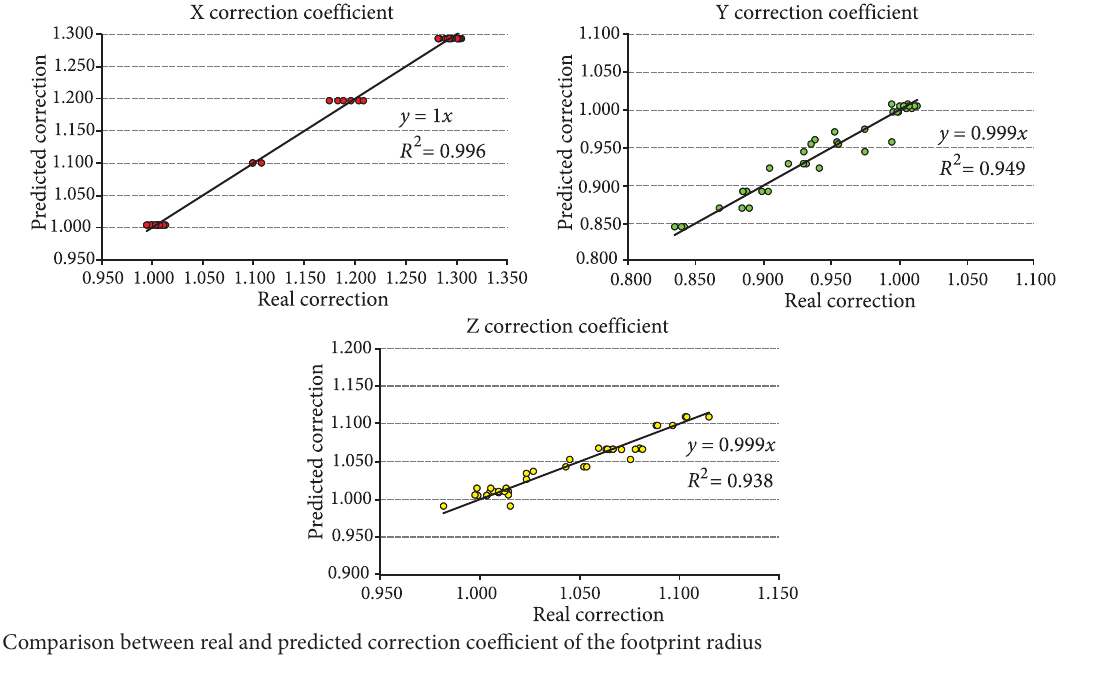
Fig. 2. Comparison between real and predicted correction coefficient of the footprint radius Table 3. Load configurations for calculation of strains outside the footprint area No. Geometric conversion